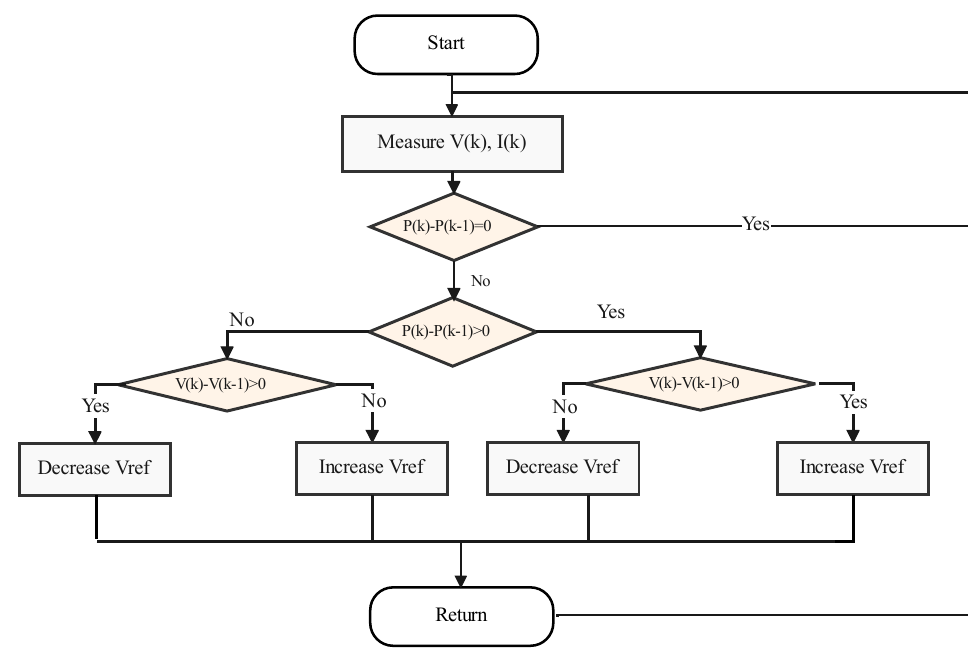
Figure 6. Flowchart of the P&O algorithm [27].